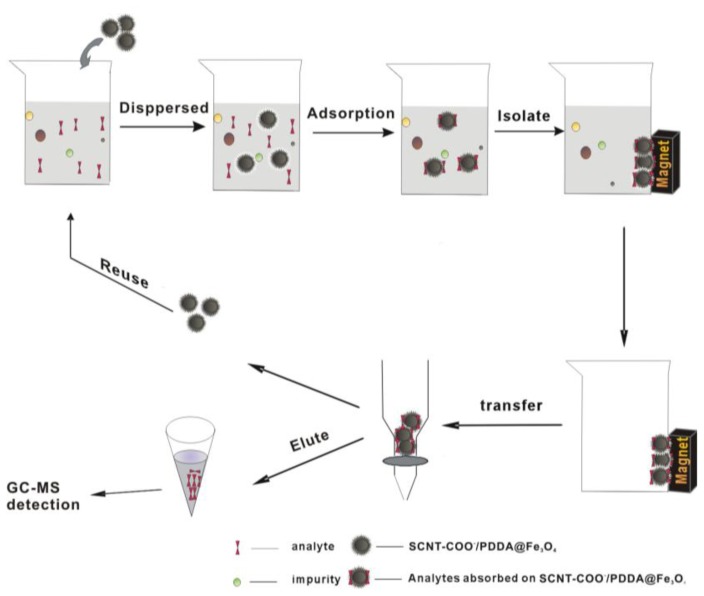
Adsorption process.